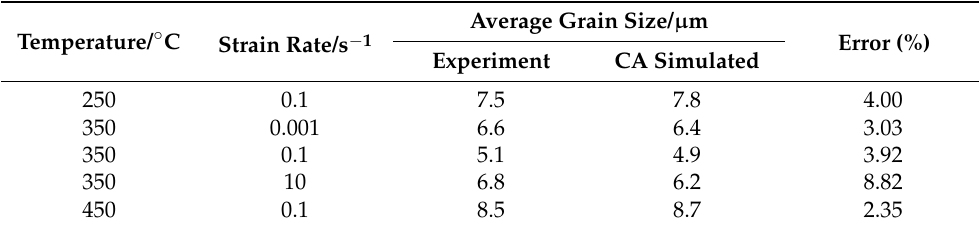
Table 2. Comparison on the average grain size between the experiment and CA simulated microstruc-